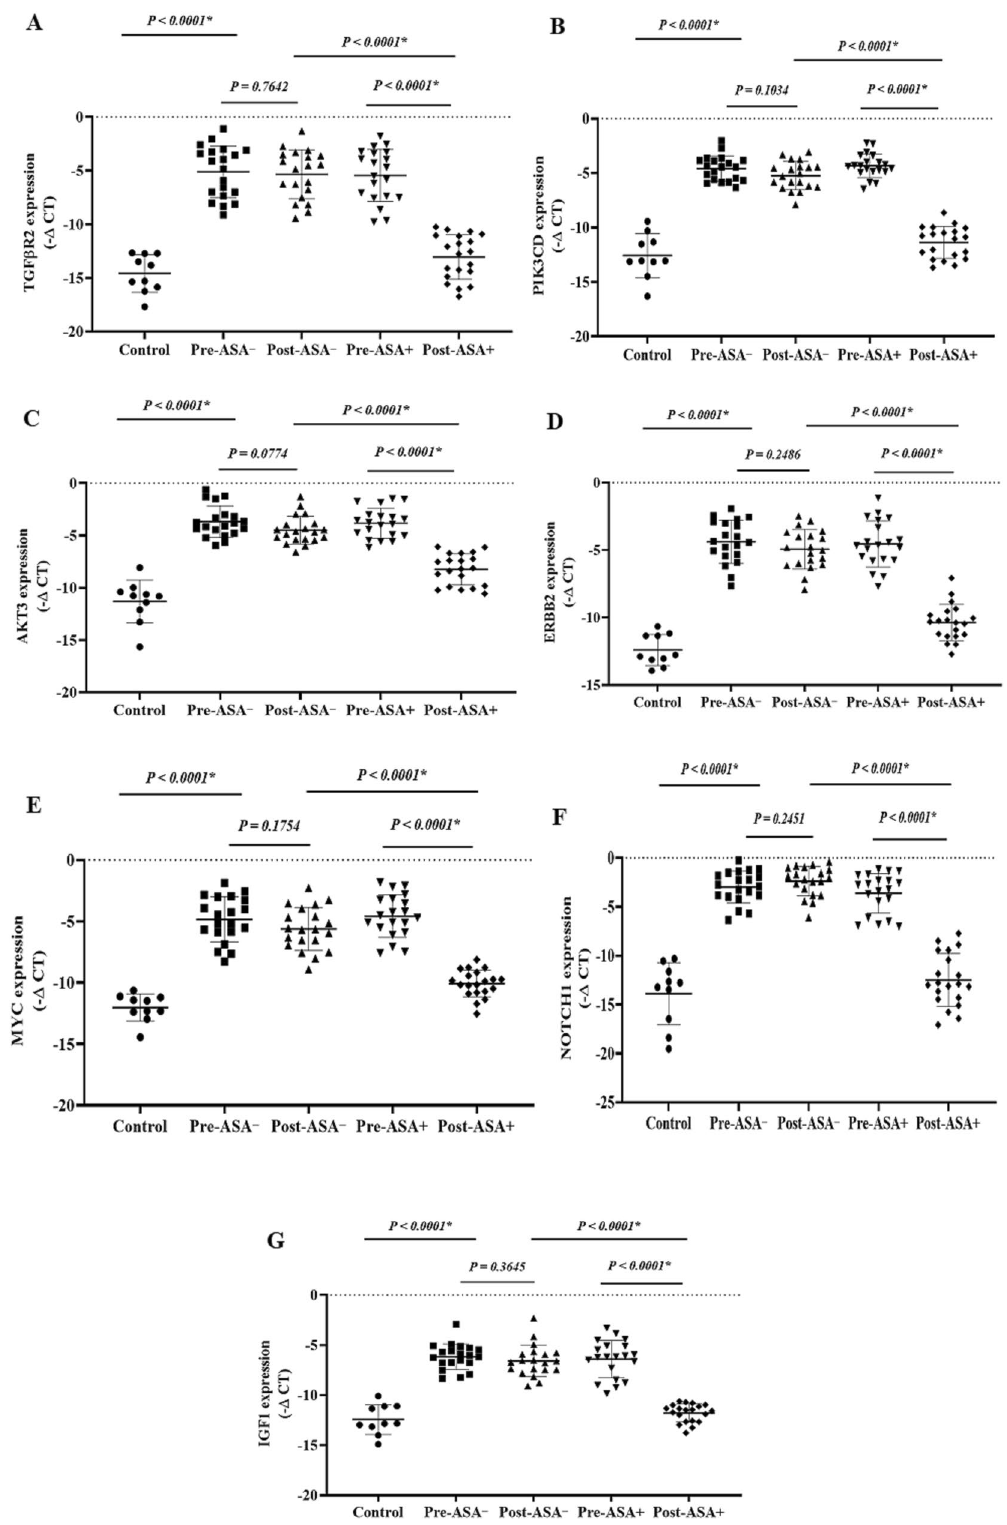
Figure 8 . The relative expression of the candidate mRNAs in the breast cancer patients. The relative expression levels of the genes were normalized by a reference gene. The oncogenes included: ( A ) TGFβR2, ( B ) PIK3CD, ( C ) AKT3, ( D ) ERBB2, ( E ) MYC, ( F ) NOTCH1, and ( G ) IGF1. Tumor suppressor genes included: ( H ) PTEN, ( I ) FOXO3, and ( J ) SOCS5. ASA−: Non-aspirin group, ASA+: Aspirin group. The expression levels of the mRNAs were calculated using the –ΔCT